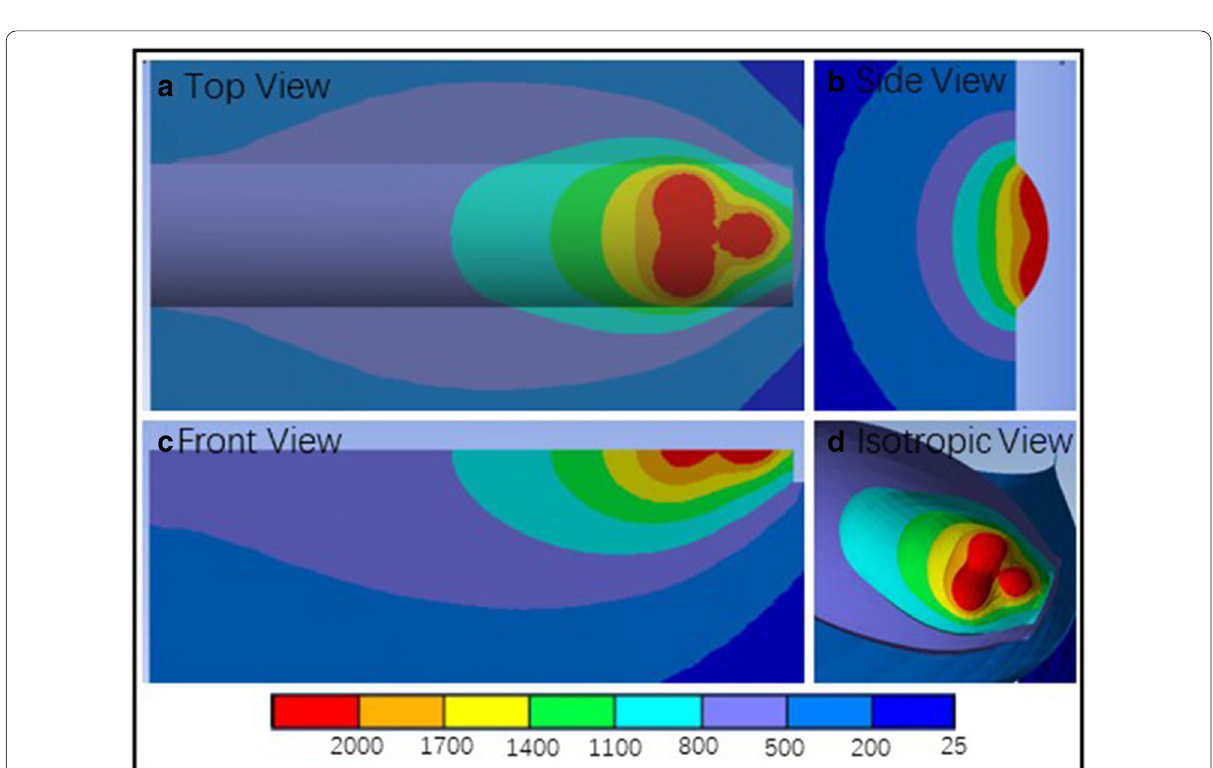
Figure 14 Temperature contour images: a top view, b side view, c front view, and d isotropic view